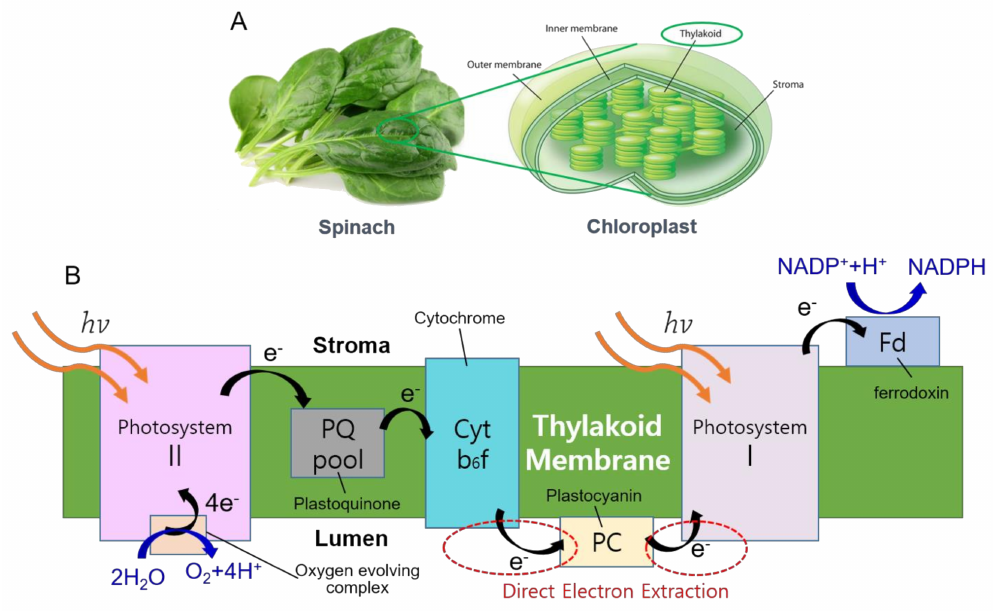
Figure 1. ( a ) Schematic of thylakoid membranes and chloroplasts from spinach leaves; and ( b ) photosynthetic electron pathway in thylakoid